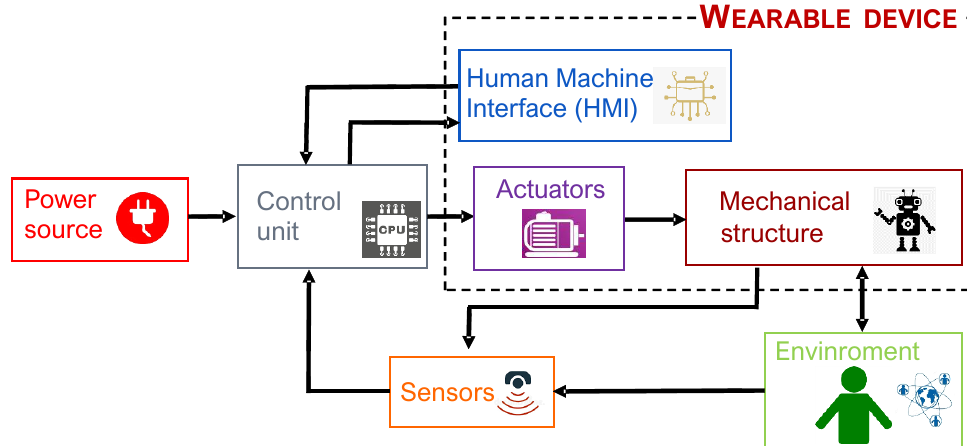
Figure 1. General architecture of a robotic exoskeleton. Actuators and sensors are fundamental elements within the overall system that constitutes the exoskeleton. Actuators are key elements in active devices, and the adopted technological choices significantly influence the device performance. Sensors are essential for the interaction with the environment, in particular with the user of the exoskeleton. The choices for actuator and sensor technologies are often